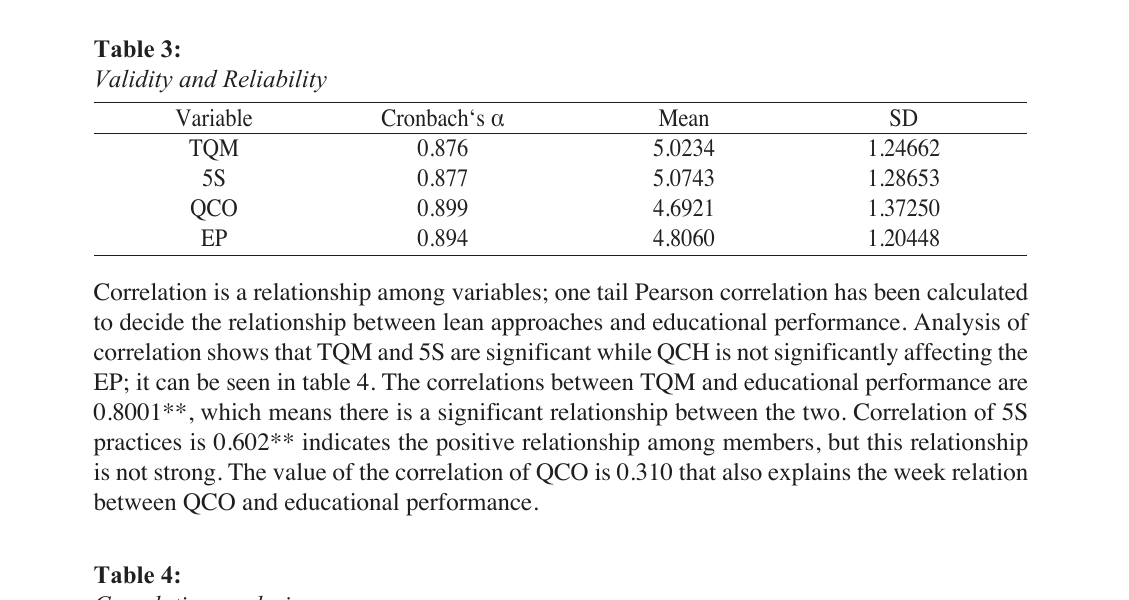
Correlation analysis TQMmean Pearson